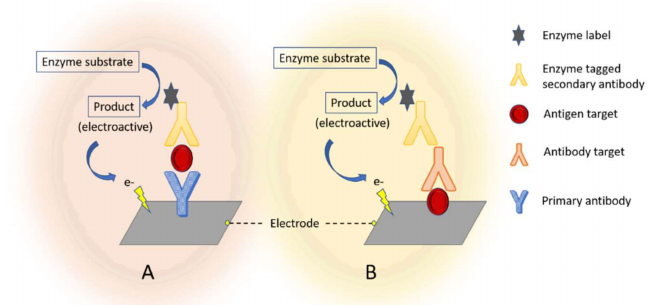
Figure 1. Scheme showing the basic components of electrochemical immunosensors with enzyme labels: A. antigen’ detection principle; B antibody’s detection principle (adapted from